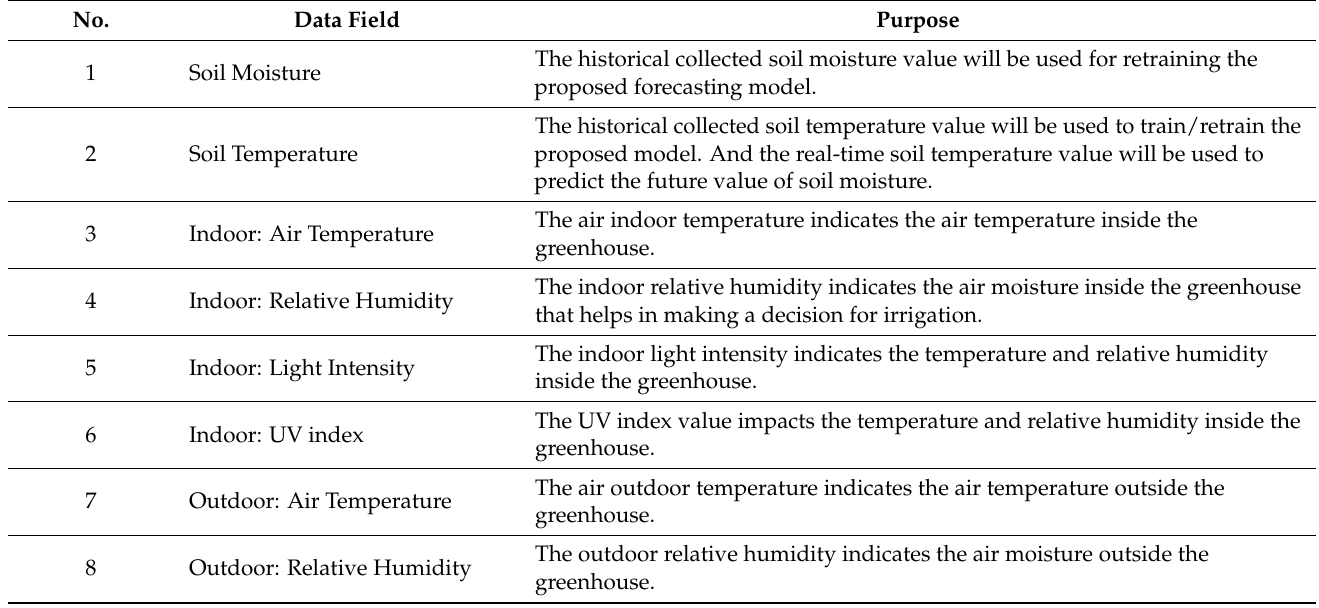
Table 2. Sample of the collected raw data.